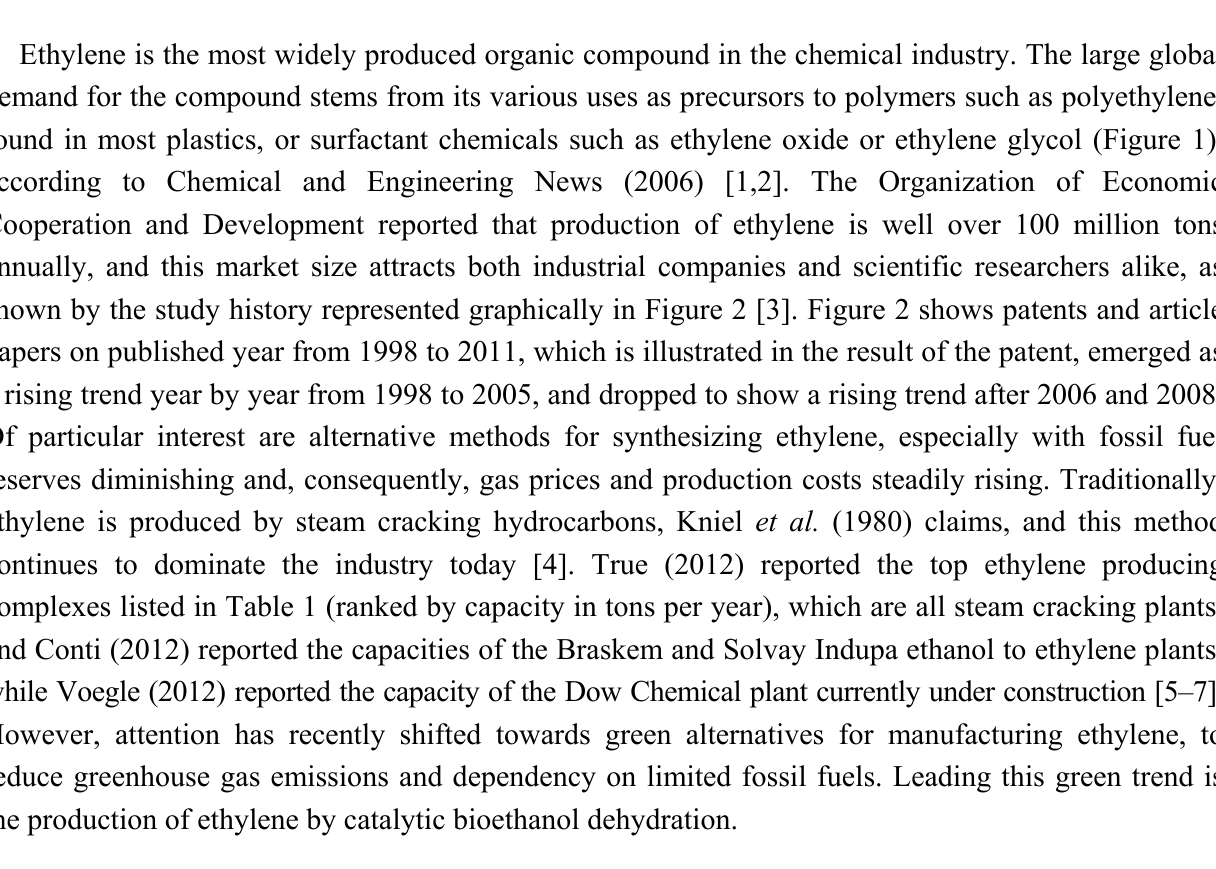
Figure 1. Main uses of ethylene in industry (left to right): polyethylene, ethylene dichloride (precursor to vinyl chloride, below), ethylene oxide (precursor to ethylene glycol, below), and ethylbenzene (precursor to styrene,